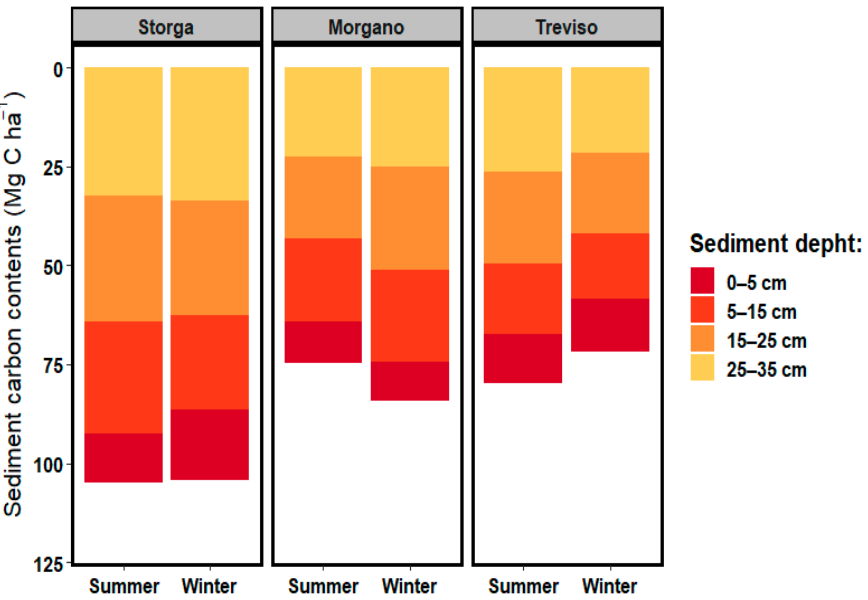
Figure 2. Distribution of sediment OC content for Sile River sampling stations.